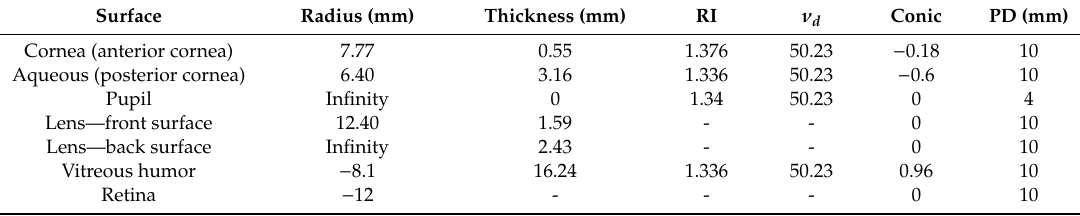
Table 1. Input parameters of the Liou and Brennan eye model (LBEM) in ZEMAX software [24]. Legend: RI, refractive index; PD, pupil diameter; v d , Abbe